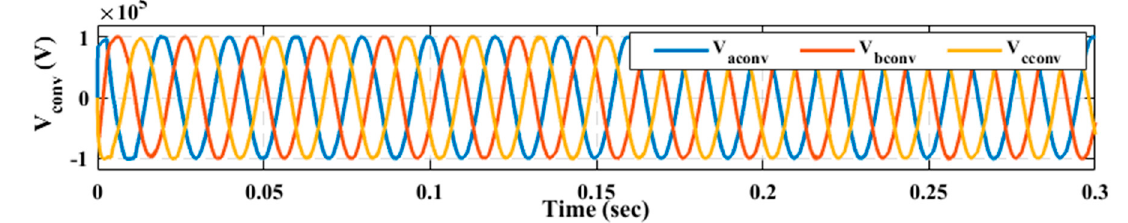
Figure 15. Output voltage.